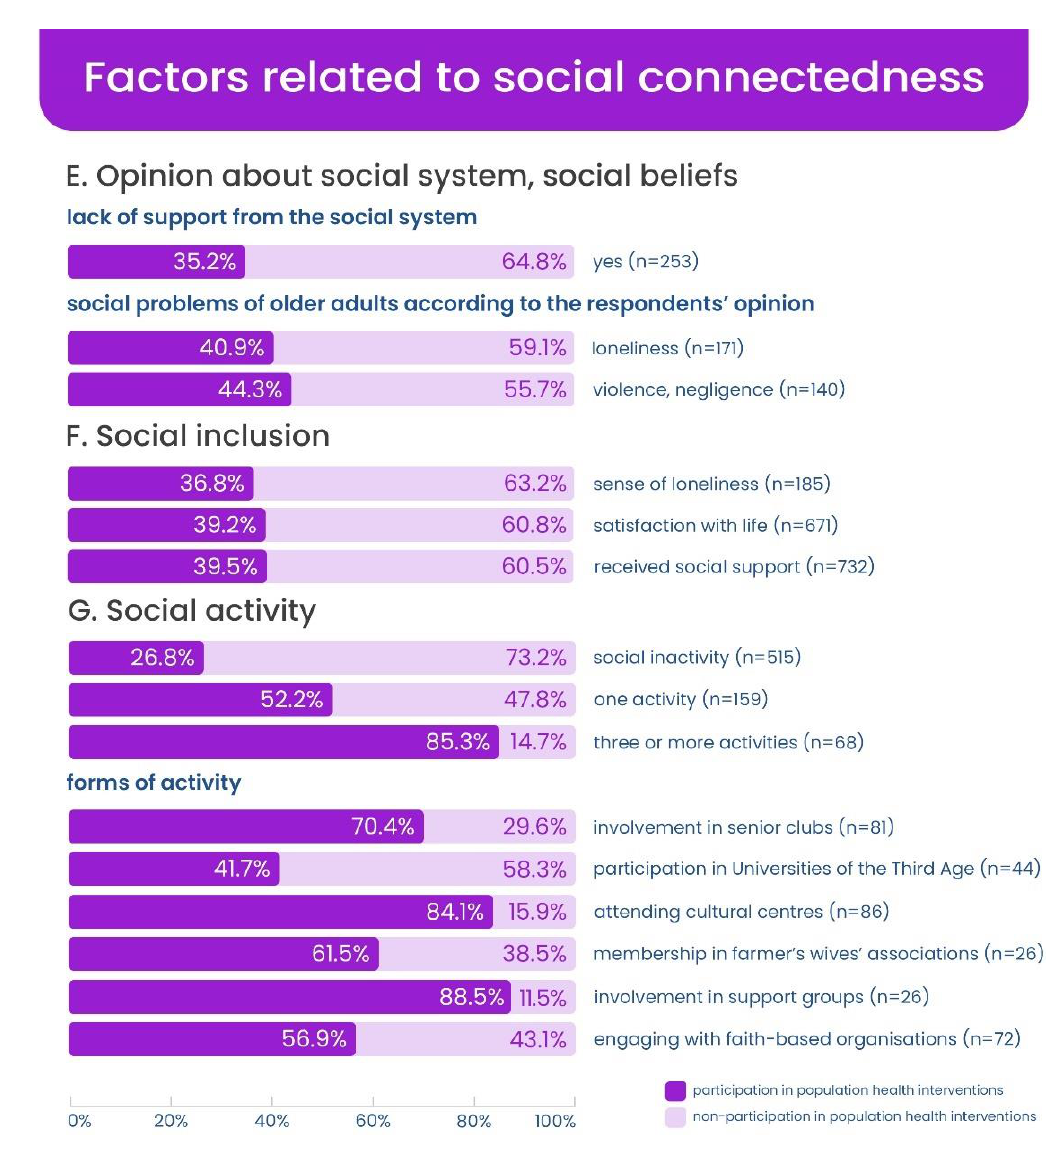
Figure 4. Participation in health programmes in subgroups (participating and non-participating) by social connectedness variables (in percentage).